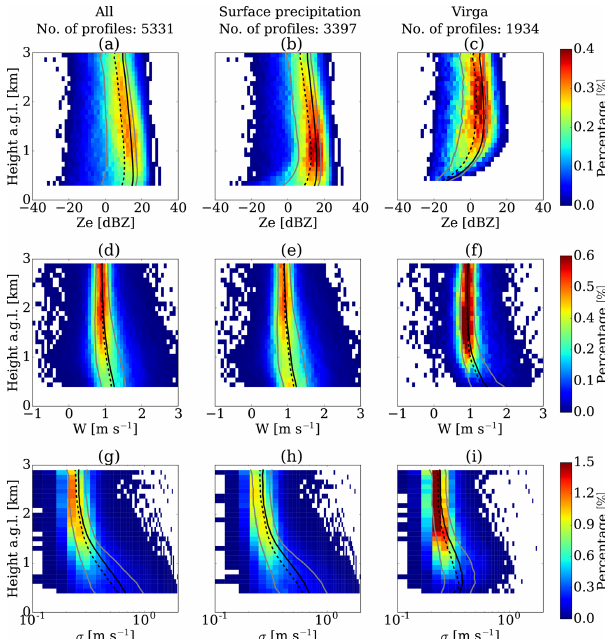
Figure 4. Frequency by altitude diagram for Ze (a, b, c) , W (d, e, f) , and σ (g, h, i) values observed at DDU, separated by type of snow- fall. Panels (a, d, g) correspond to all the profiles, panels (b, e, h) to surface precipitation, and panels (c, f, i) to ice virga. Solid black and dashed black lines represent the average and median vertical profiles of Ze, W , and σ . Grey lines correspond to the 20% and 80% quantiles of the vertical profiles. σ values are plotted on the log x axis to highlight the variations for small